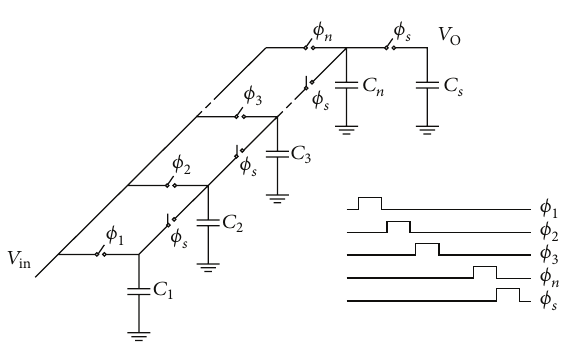
Figure8:Switchedcapacitorimplementationofapassive 𝑁 -tapFIR with a decimation by 𝑁 .